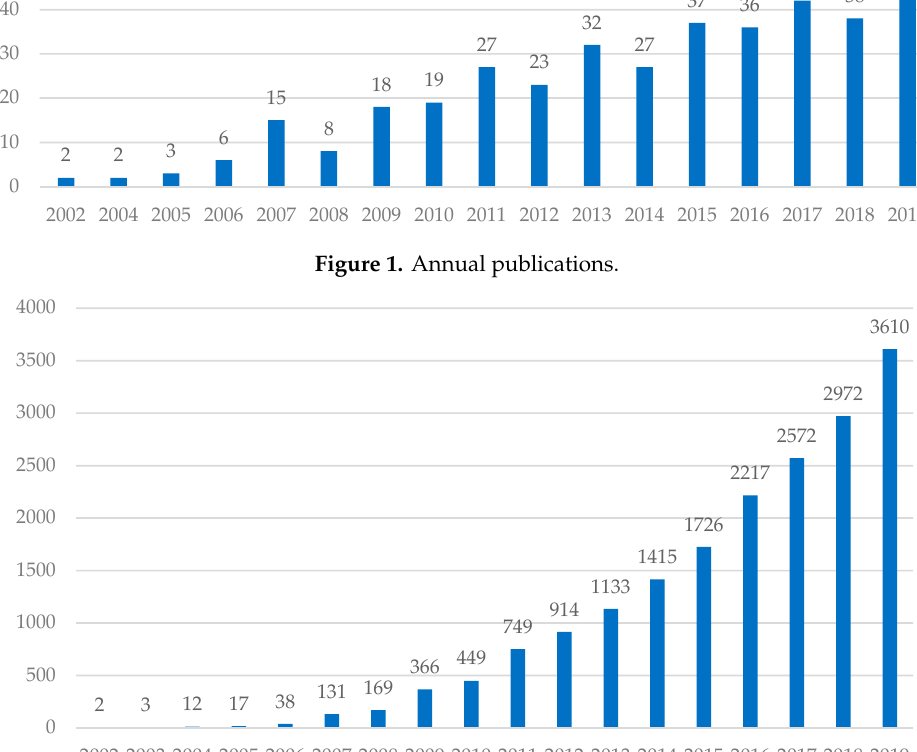
Table 3. Journal productivity.